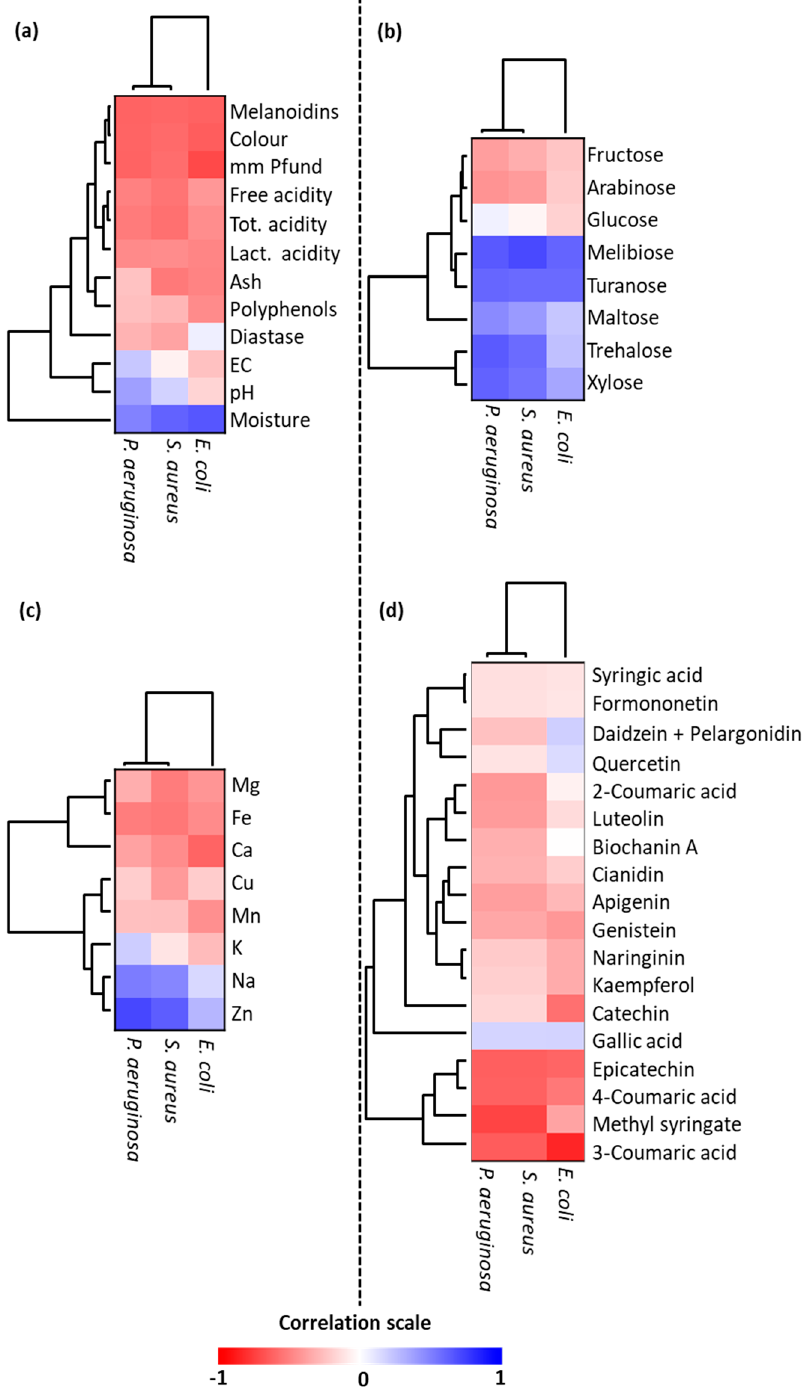
Figure 3. Heat map and dendrogram illustrating the correlation between physicochemical parameters and antimicrobial activity (MIC values) for E. coli , P. aeruginosa and S. aureus . ( a ) Physicochemical properties, ( b ) sugar composition, ( c ) mineral composition, ( d ) polyphenol composition.